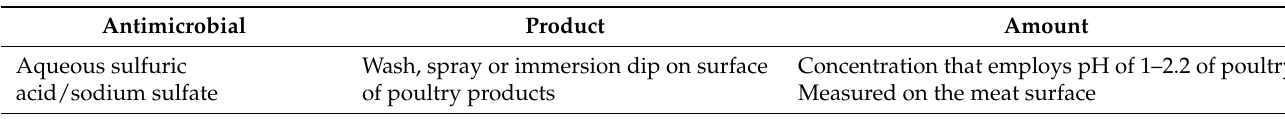
Table 4. Some of the widely used safe and suitable antimicrobials stipulated for use in poultry processing to produce raw poultry meat products in the United States (data from